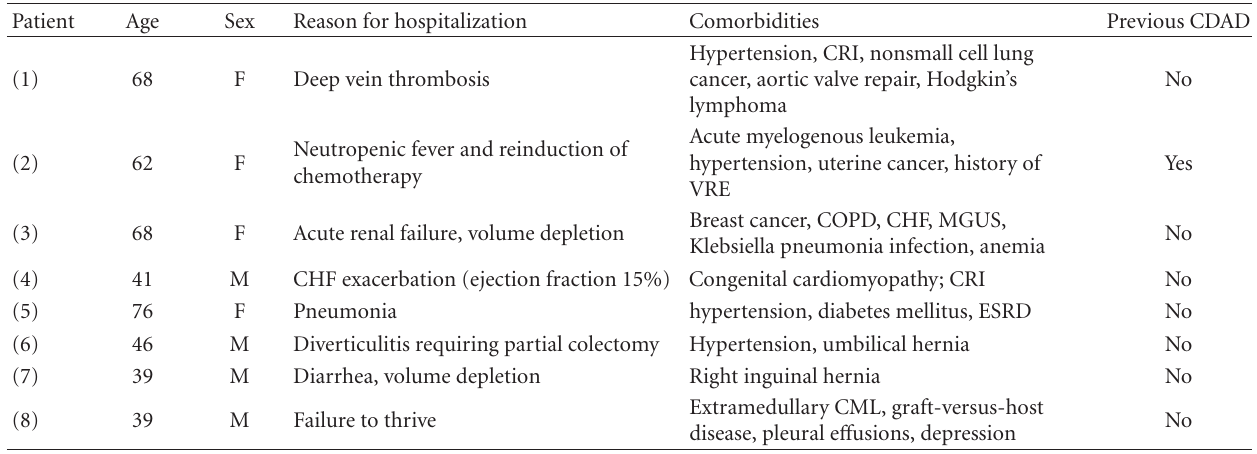
Table 1: Patient demographics and characteristics.